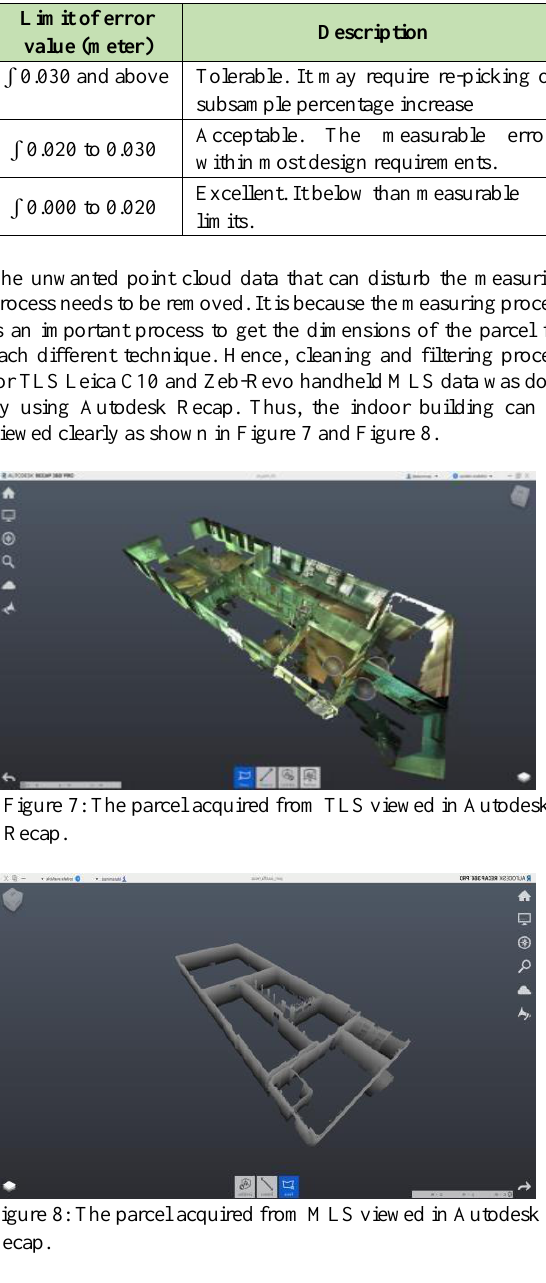
Table 1: Error value in cloud constraint